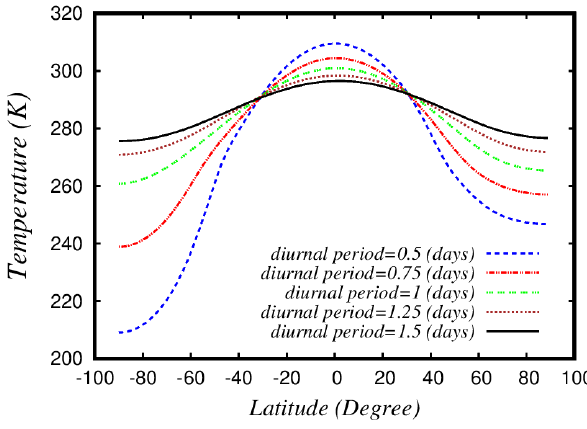
Figure 9. Simulation for a Sun-Earth system with different diurnal period of the Earth shows that increasing this parameter results in a more homogeneous temperature